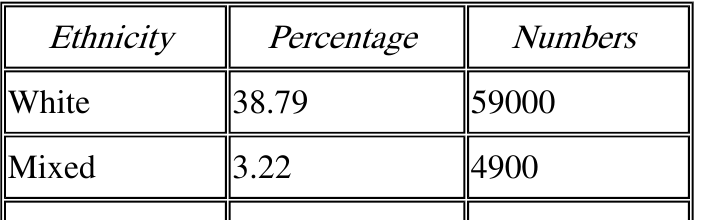
Table 2: Ethnicity of Buddhists in the